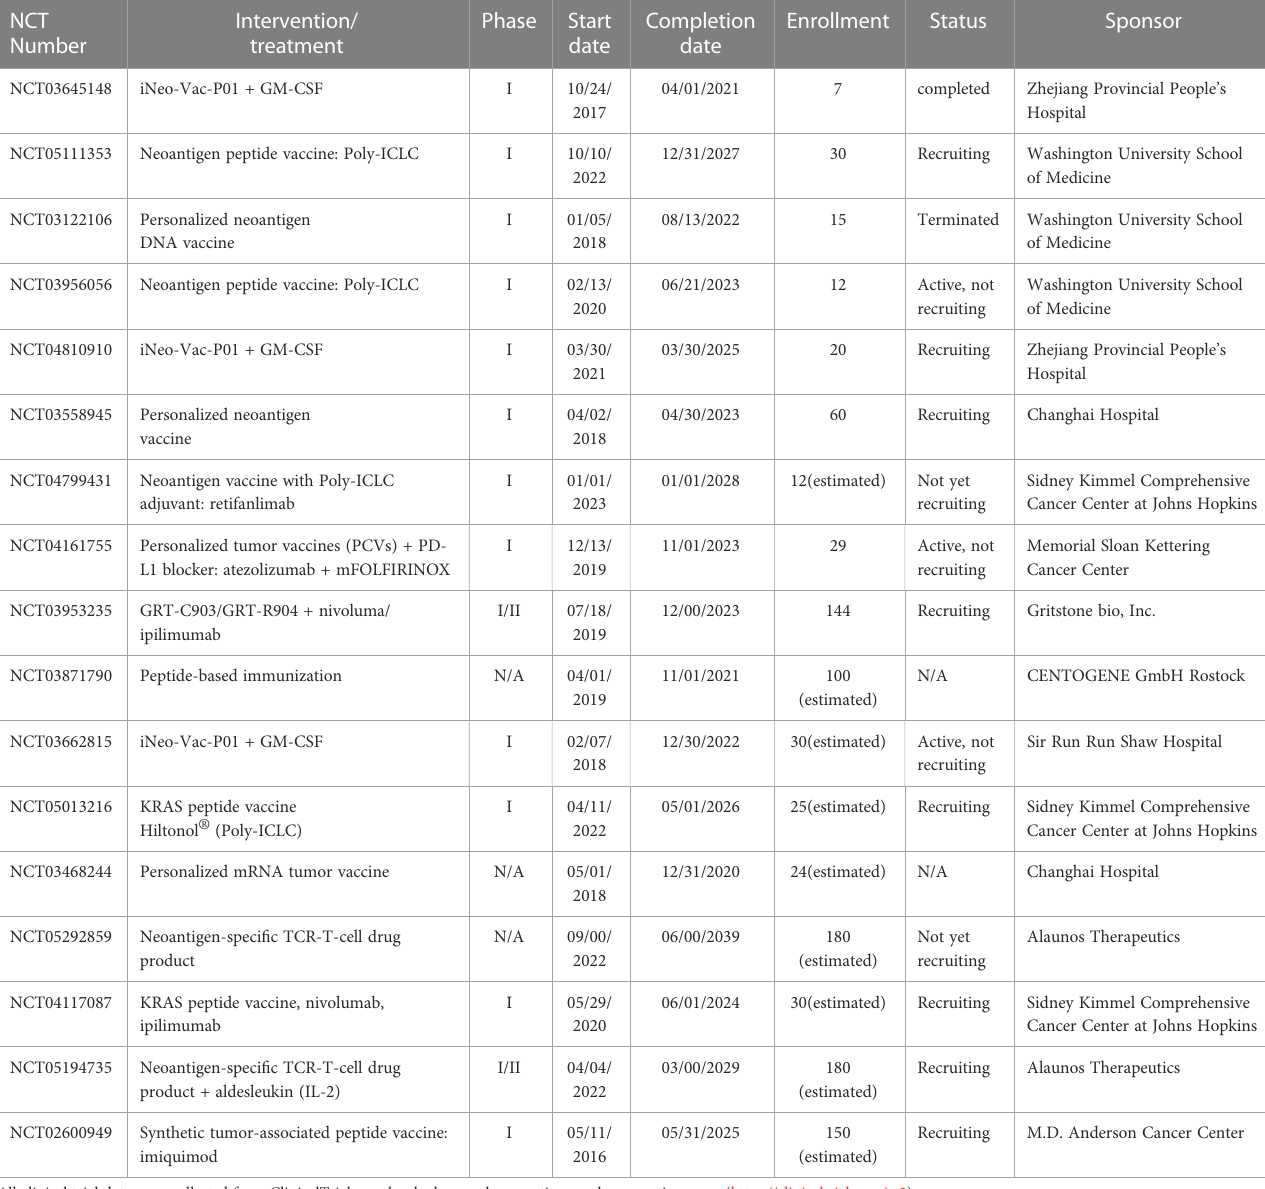
TABLE 2 Clinical trials of neoantigen-based therapies on